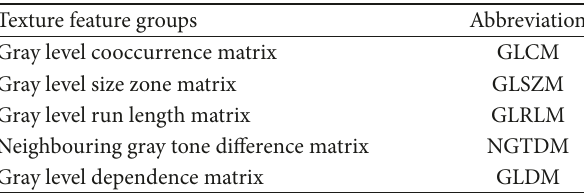
Table 1: Texture